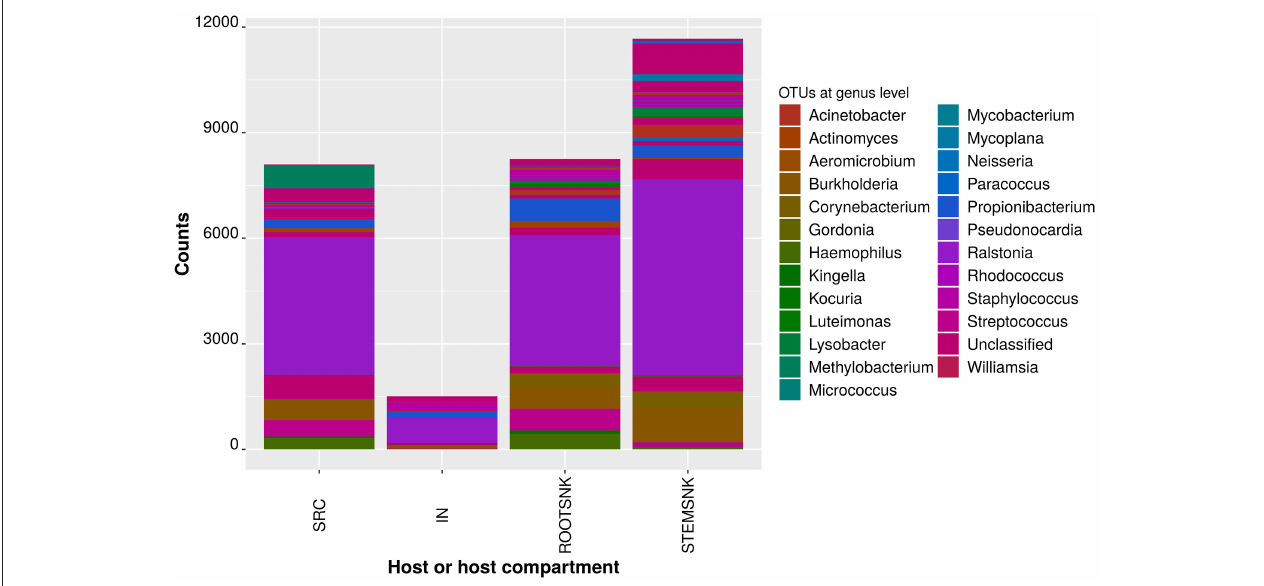
FIGURE 4 | Comparisons of statistically significant abundances per sample category in a rarified OTU table. Frequencies per sample categories with non-normal distribution were compared using the Kruskal–Wallis test as implemented in QIIME. Only SRC, IN, STEMSNK, and ROOTSNK were analyzed. The probability of finding at least one mean significantly differing from the others was corrected using the False Discovery Rate (FDR) and the Bonferroni procedures, as implemented in QIIME.